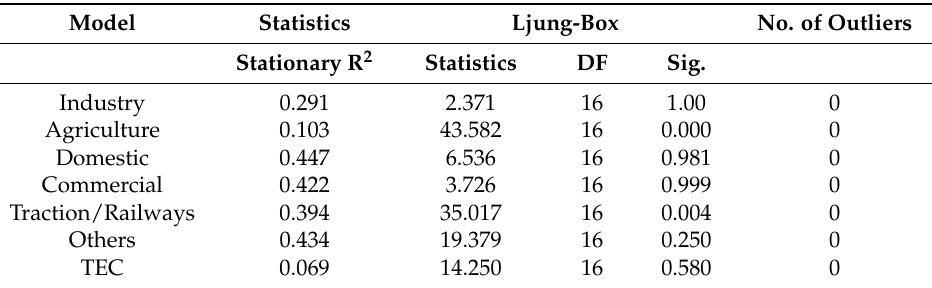
Table 8. Summary of Holt’s